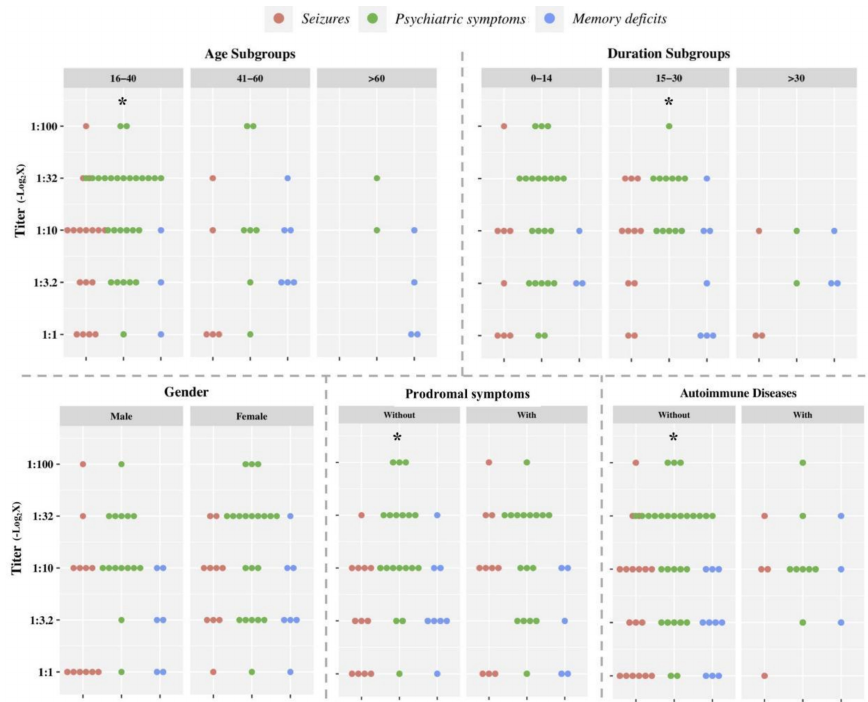
Figure 3. Cerebrospinal fluid antibody titers (with negative-logarithmic transform) compared be- tween 3 onset-phenotype subgroups according to each factor (* with a significant difference between the 3